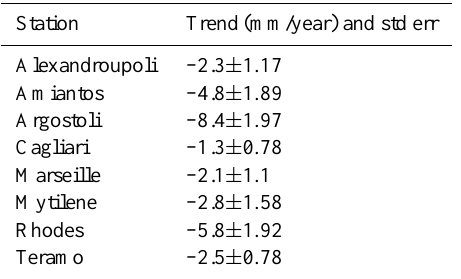
Table 2. Estimated trend in the seasonal precipitation series. Only the significant ( ≥ 90%) values and associated uncertainties are re- ported. The significance is derived with the Mann-Kendall test (Yue et al., 2002).